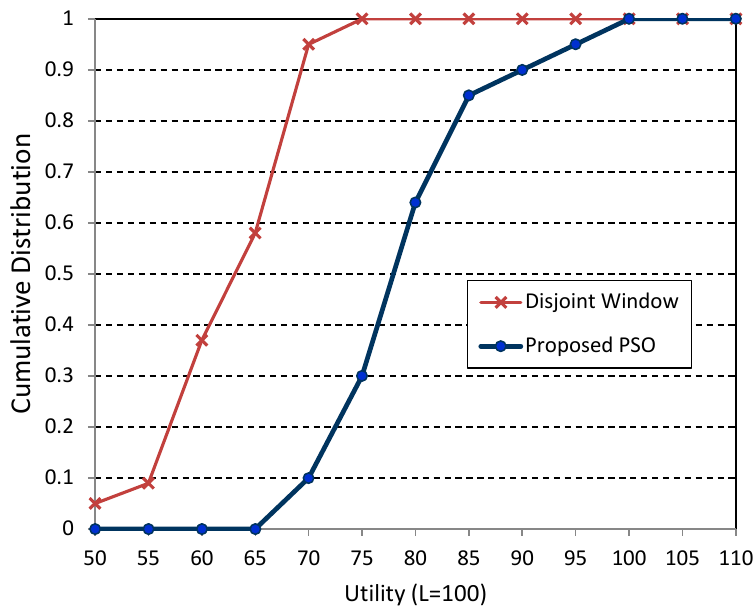
Figure 9. Utility cumulative distribution function.